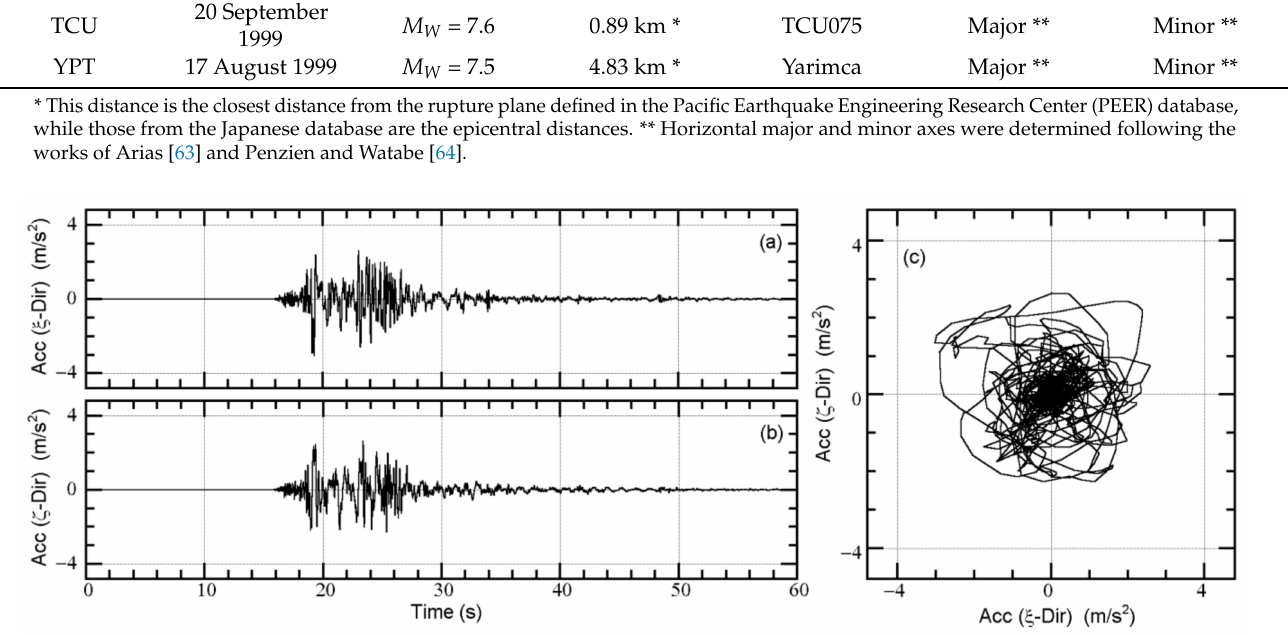
Figure A1. Two components of the recorded ground motion (UTO0414): ( a ) ξ direction; ( b ) ζ direction; ( c ) orbit.